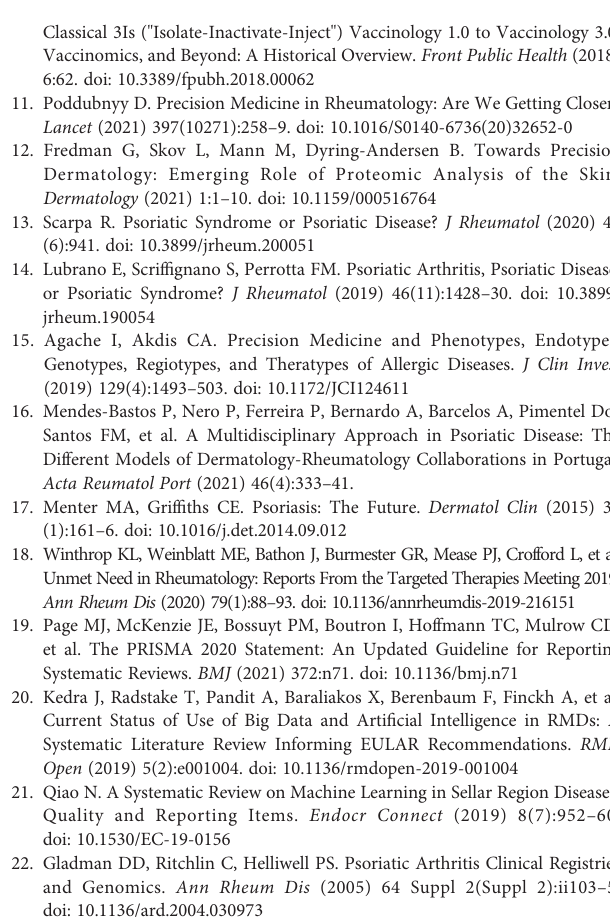
Supplementary Table 5 | Outcomes of the assessment of the trustworthiness, relevance, and results of the studies retained in the present systematic literature review,based ontherelevant JoannaBriggsInstitute(JBI) ’ scriticalappraisal toolfor the critical methodological quality assessment (namely, the “ Explanation of text